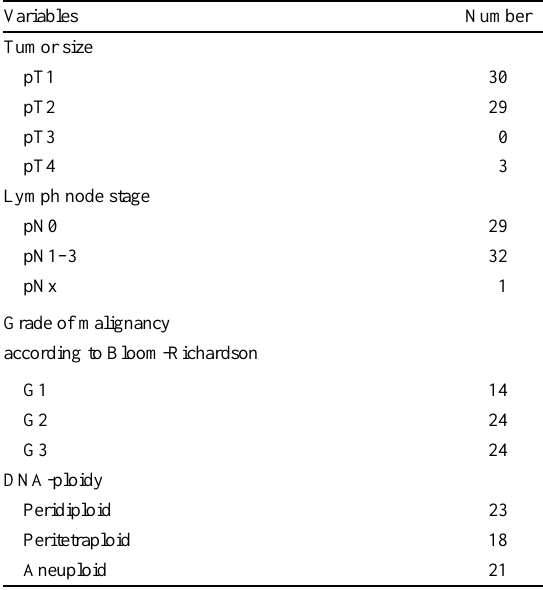
Clinicopathological variables and the DNA ploidy of the studied breast cancers